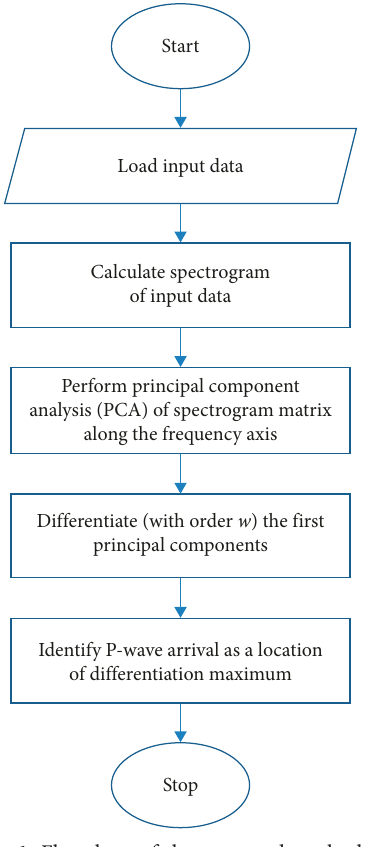
Figure 1: Flowchart of the proposed